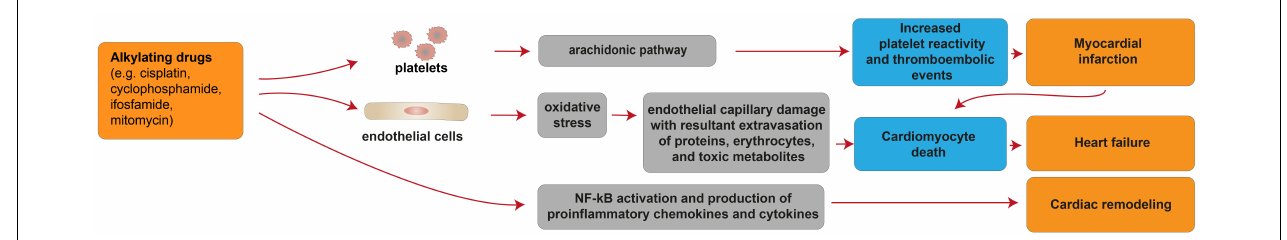
FIGURE 4 | Cellular and molecular mechanisms of the cardiotoxic effects exerted by alkylating drugs. Schematic diagram showing the impact of alkylating agents in promoting heart failure due to cardiomyocyte death consequent to myocardial infarction. Additional mechanisms of alkylating drug-induced cardiotoxicity include heart failure consequent to cardiomyocyte death induced by oxidative stress and cardiac remodeling following activation of pro-inflammatory